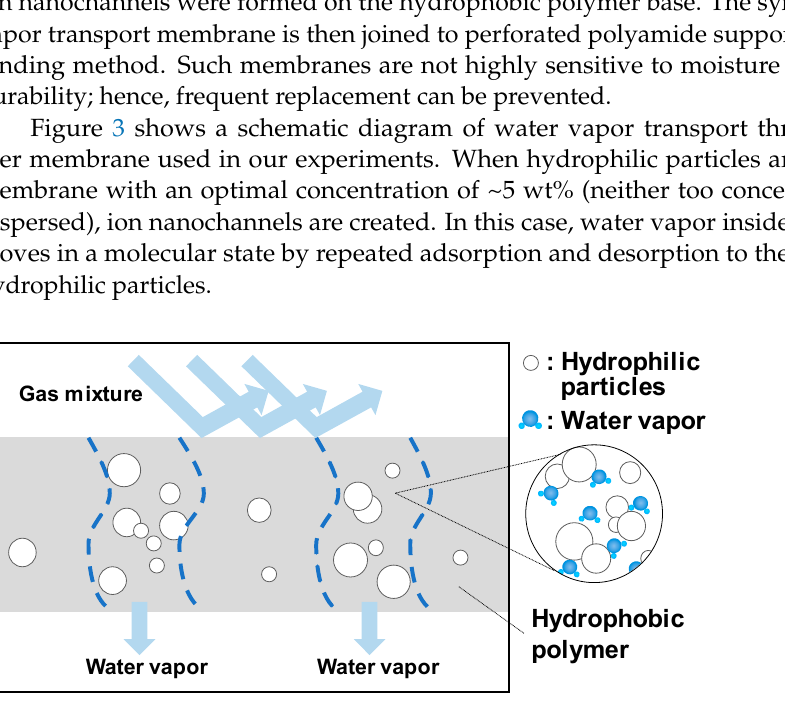
Figure 3. Schematic diagram of water vapor transport through the polymer membrane used in the experiments.